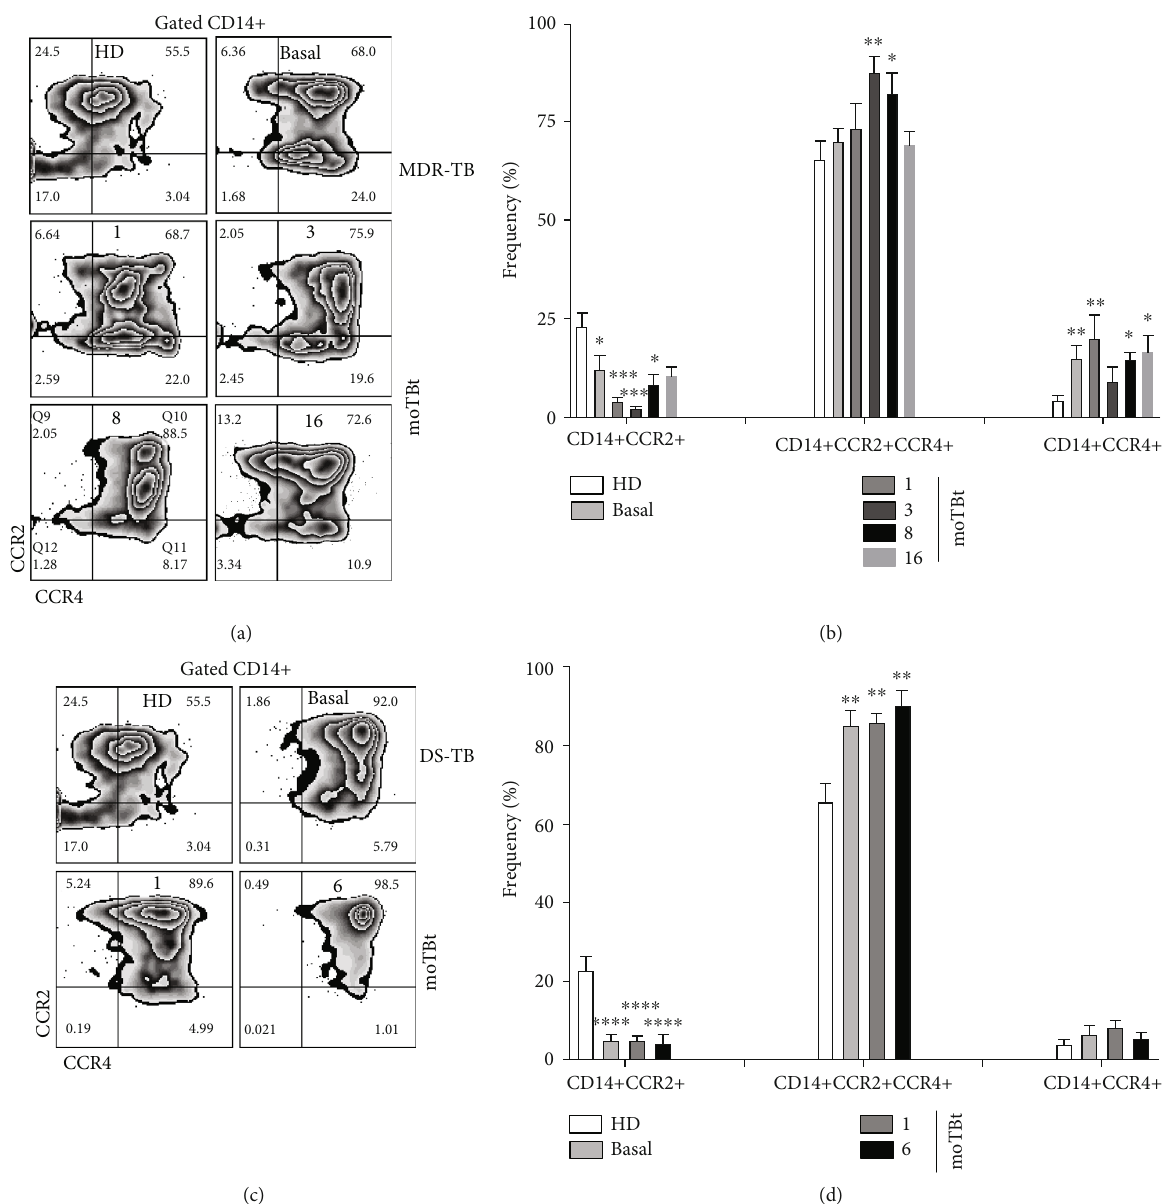
Figure 3: Di ff erential expression of CCR2 and CCR4 in peripheral blood monocytes from MDR-TB and DS-TB patients. Representative zebra plots showing the strategy of analysis used to evaluate CCR2 and CCR4 expression in total CD14+ monocytes by fl ow cytometry. Peripheral blood mononuclear cells (PBMCs) from multidrug-resistant (MDR-TB) or drug-sensitive (DS-TB) patients were obtained at di ff erent time points before and after anti-TB treatment and employed for phenotypical characterization (a and c, respectively). (b) Frequency of CD14+CCR2+, CD14+CCR2+CCR4+, and CD14+CCR4+ subpopulations in MDR-TB patients (HD: n = 6 , MDR-TB: basal, 1, and 3 moTBt n = 10 , 8 moTBt n = 8 , and 16 moTBt n = 7 ). (d) Frequency of CD14+CCR2+, CD14+CCR2+CCR4+, and CD14+CCR4+ subpopulations in DS-TB patients (HD n = 6 ; DS-TB: basal, and 1 moTBt n = 10 , and 6 moTBt n = 8 ). Bar graphs display means ± standard errorof themean ð SEM Þ . Di ff erences between patient groups and HD at each time point were analyzed using multiple Student ’ s t -test corrected for multiple comparisons using the Sidak – Bonferroni method. ∗ p < 0 : 05 , ∗∗ p < 0 : 01 , ∗∗∗ p < 0 : 001 , and ∗∗∗∗ p < 0 : 0001 . moTBt: months of antituberculosis